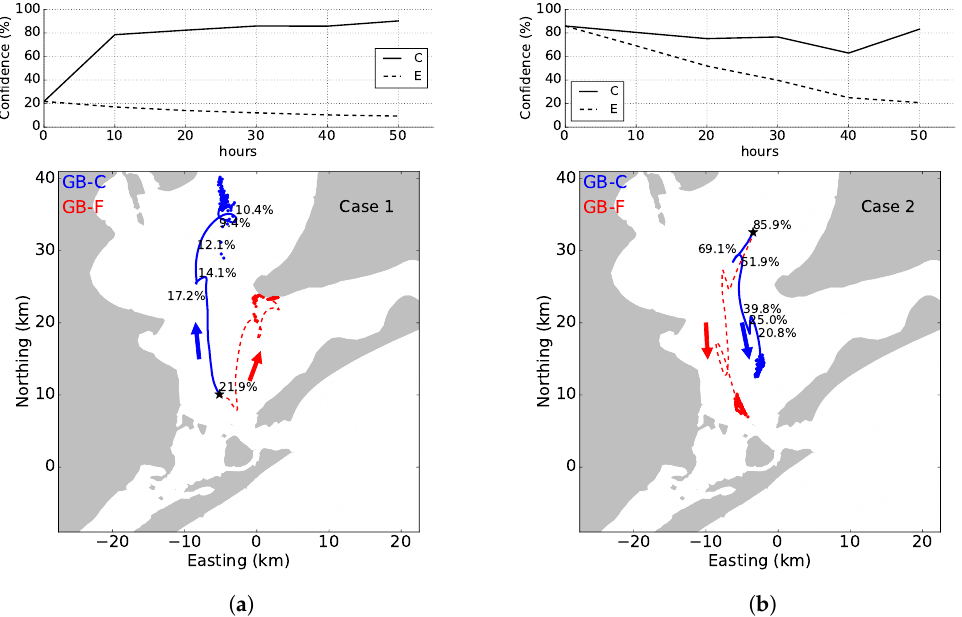
Figure 10. The spill trajectories predicted by GB-C and GB-F models, and the estimated confidence degree ( C ) and the effective confidence ( E ) of the uncertainty model for ( a ) Case 1 and ( b ) Case 2. The GB-C trajectory is annotated with E . The star is the initial spill location and the arrows represent the general direction of the spill movement.